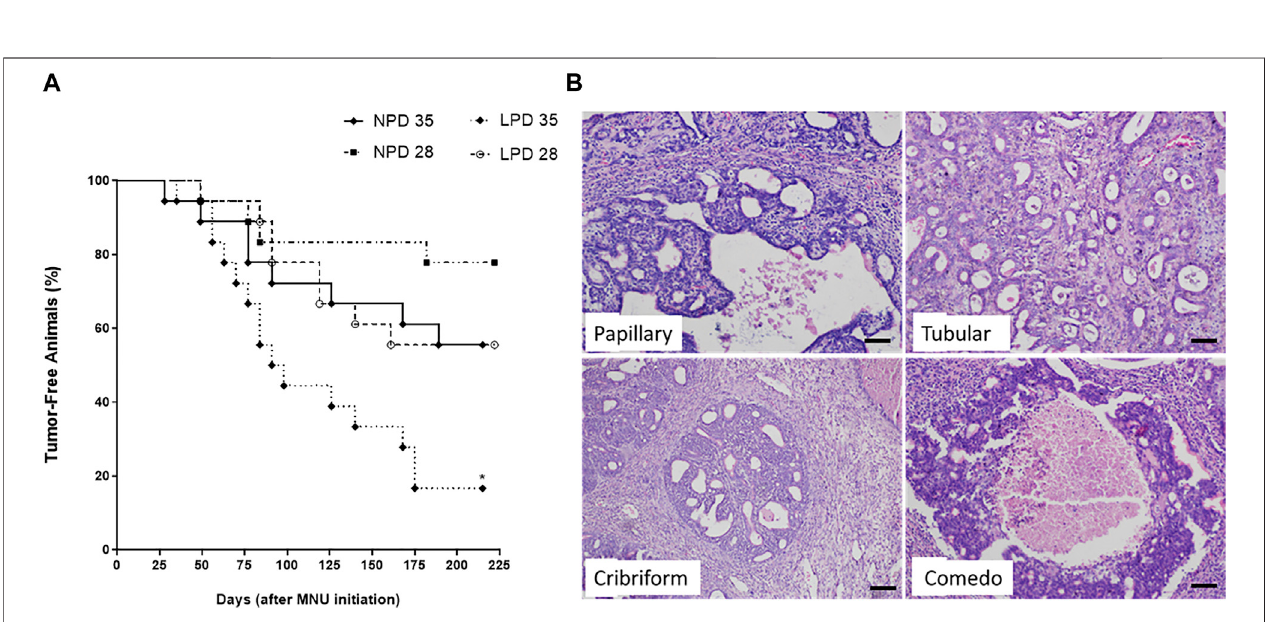
Frontiers in Cell and Developmental Biology |